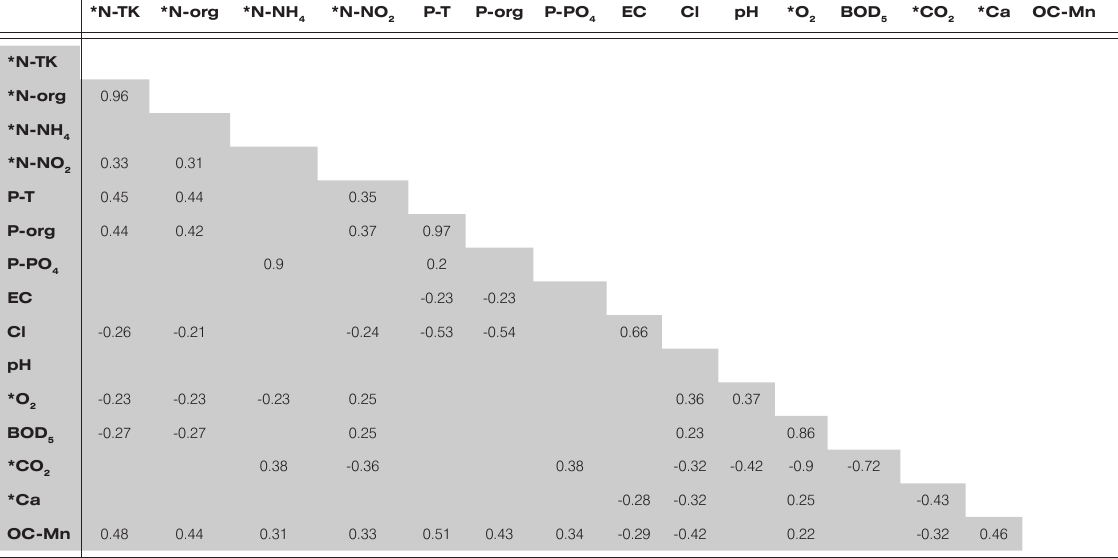
Table 5. The matrix of Spearman correlation of concentration of the analysed parameters in PM, SM and SSW layers are treated together. statistical important – p<0.05, * source: Antonowicz et al . [ 2